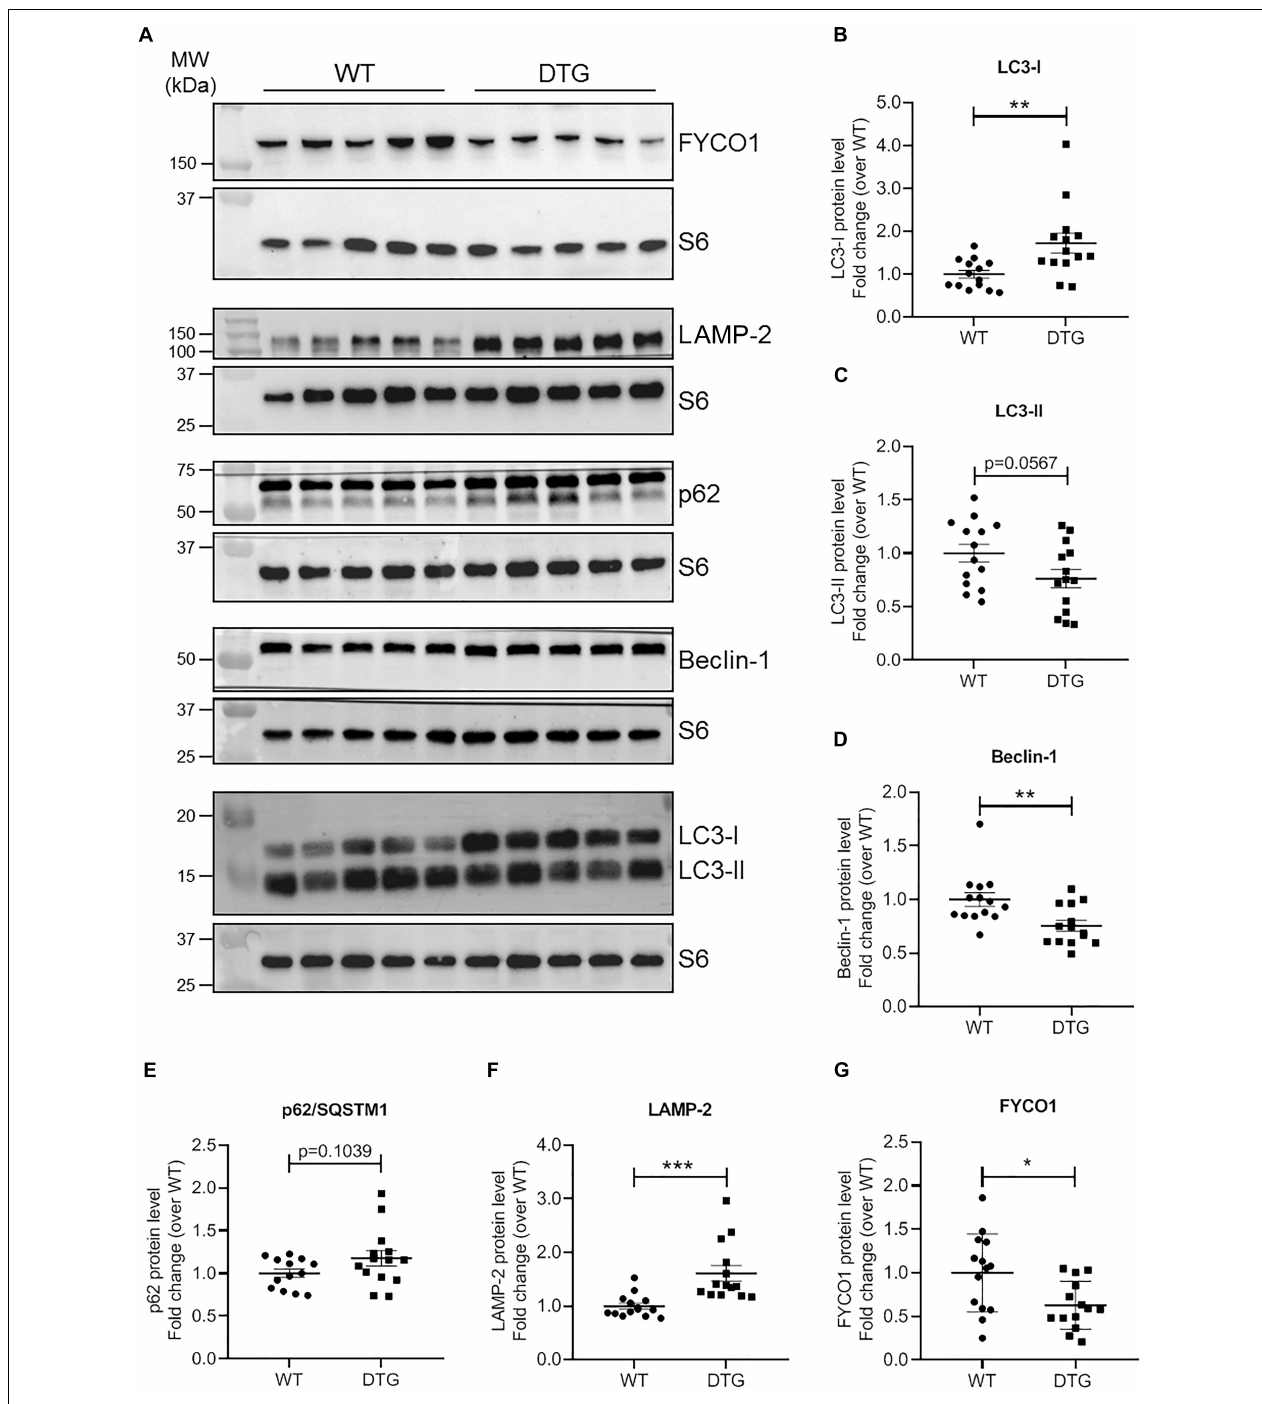
FIGURE 4 | ALP marker proteins in DTG and WT mice. (A) Representative Western blots of indicated proteins. S6 ribosomal protein was used as loading control. Quantification of (B) LC3-I, (C) LC3-II, (D) Beclin-1, (E) p62/SQSTM1, (F) LAMP-2, and (G) FYCO1 protein levels normalized to S6 ribosomal protein and related to WT. Data are presented as mean ± SEM with * p < 0.05, ** p < 0.01 and *** p < 0.001 vs. WT, unpaired Student’s t -test. N = 13–14.